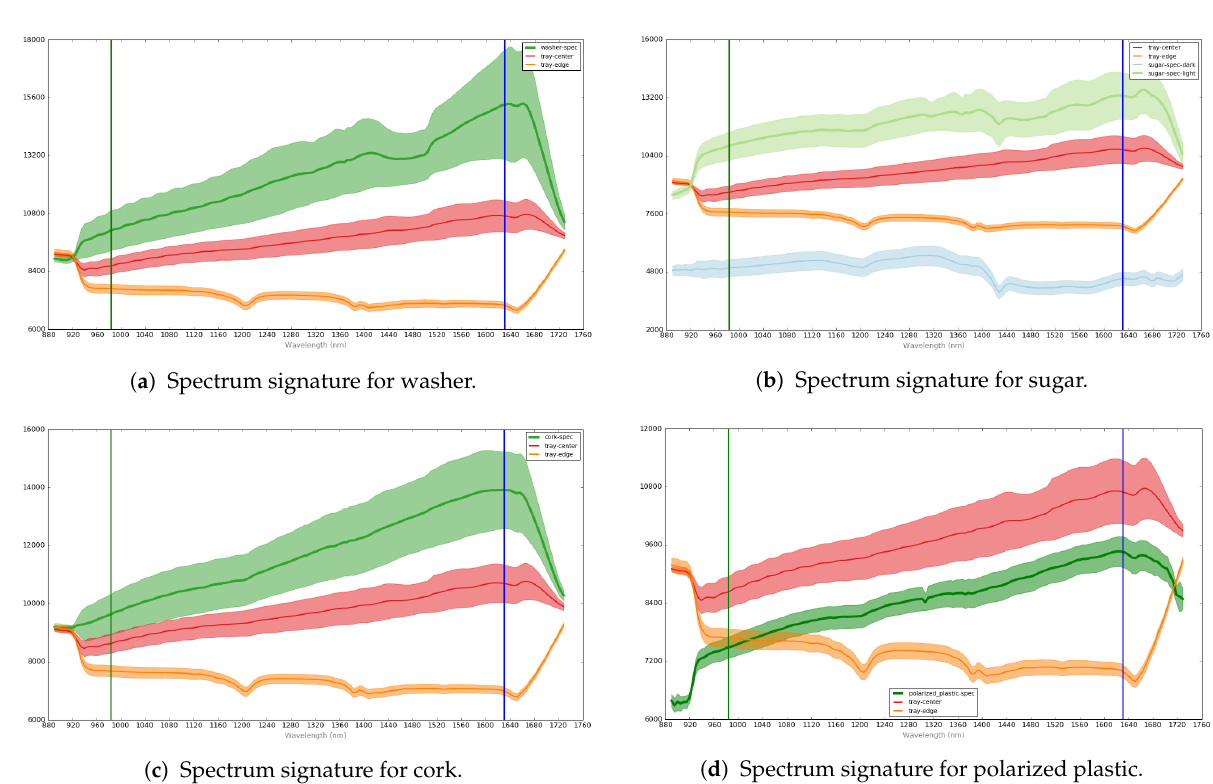
Figure 2. Spectrum signatures for some defects in food tray packaging in different tray areas: anomaly region (green), the edge region (tray—edge label, orange area), inner region of the tray (tray—center label, red